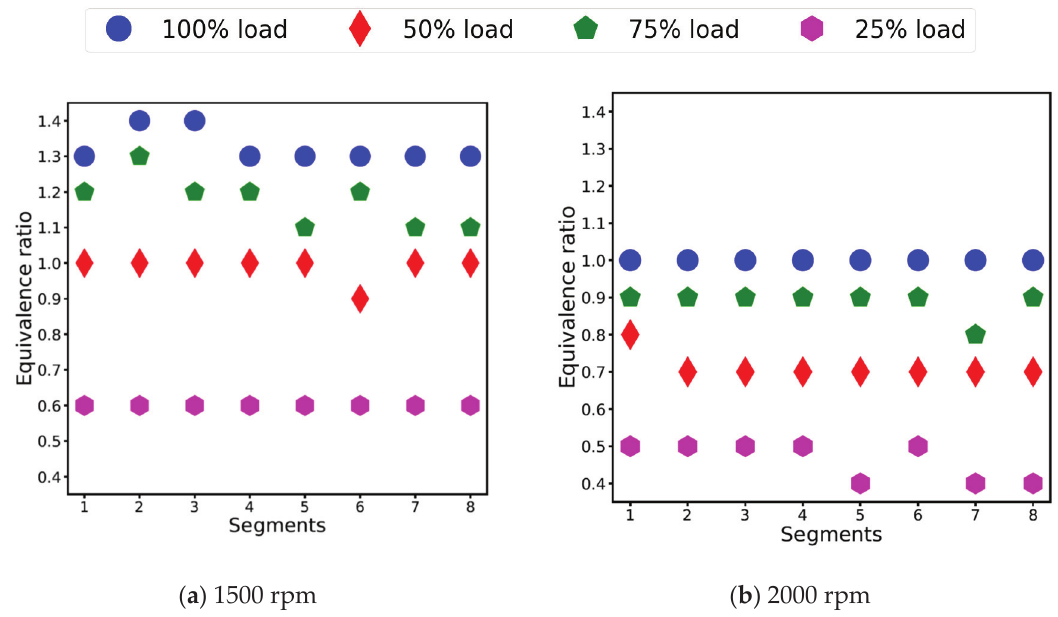
Figure 17. Fuel-to-air equivalence ratio at each load in each segment at ( a ) 1500 and ( b ) 2000 rpm. The blue circle represents 100% load, the red diamond 50% load, the green pentagon 75% load and the pink hexagon 25%